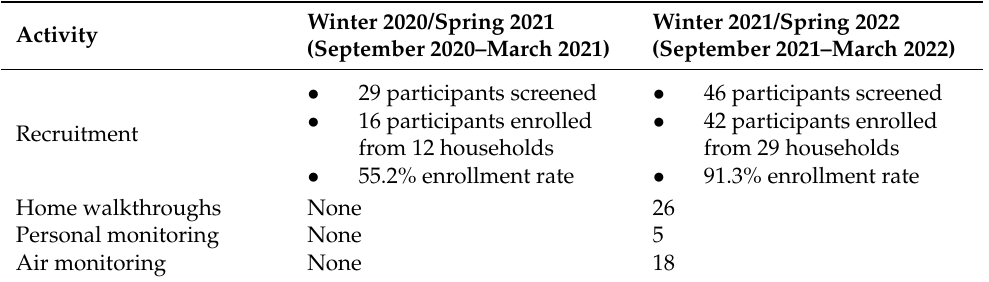
Table 3. Comparison of recruitment and enrollment efforts between winter 2020/spring 2021 and winter 2021/spring 2022.